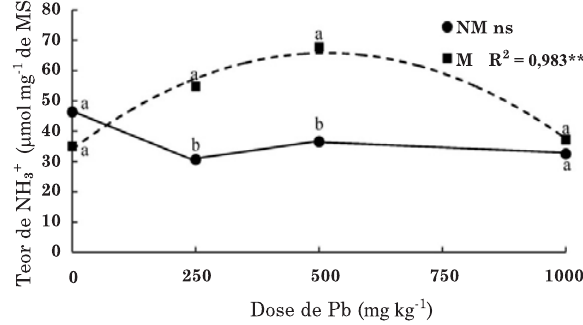
Figura 6. Atividade da nitrogenase em nódulos de raízes de plantas de Stizolobium aterrimum não micorrizadas (NM – linha contínua) e micorrizadas (M – linha tracejada) crescendo em solo com doses crescentes de Pb. Letras iguais não diferem entre si pelo teste de Tukey a 5 % entre os tratamentos NM e M, dentro de cada dose de Pb. ns: regressão não significativa.